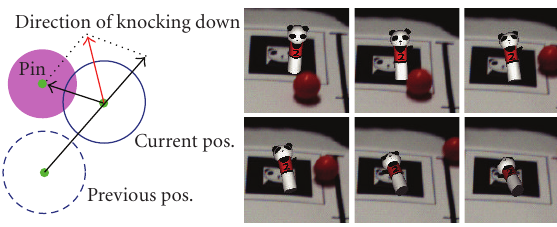
Figure 17: Direction of knocking